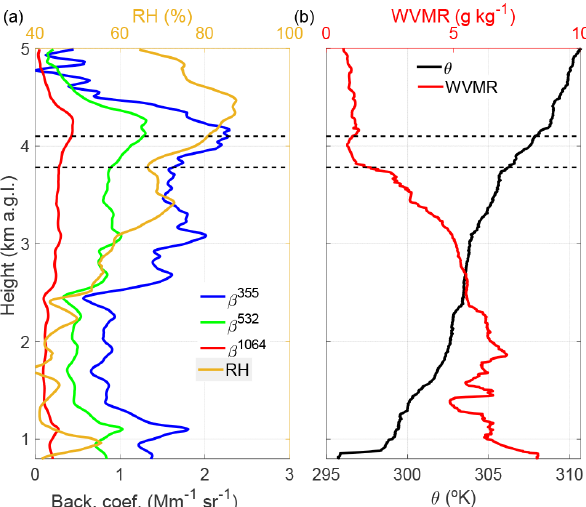
Figure 1. Vertical profiles of (a) β λ at 3 wavelengths and RH; (b) WVMR and θ . The horizontal dash lines indicate h min and h max obtained by applying the criterion-based procedure. The example is from 22 July, 2013, at 13:02UTC.